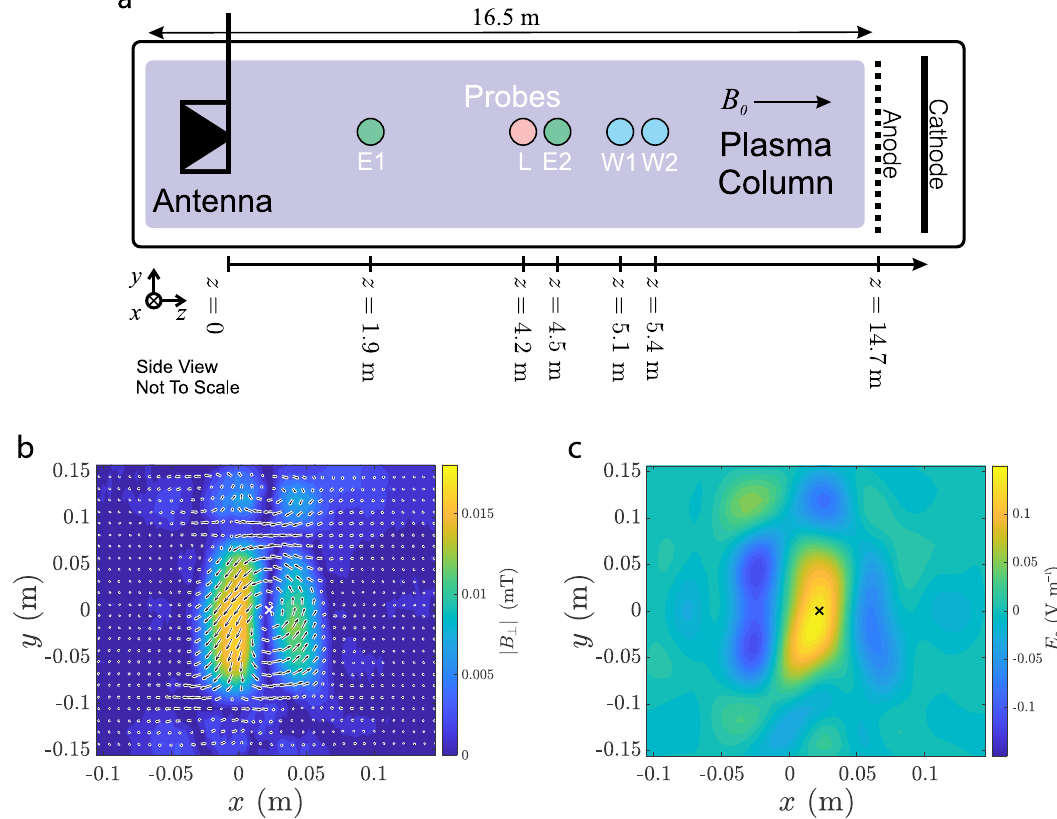
Fig. 1 LAPD setup and snapshots of the Alfvén wave. a Experimental setup showing the Sigma antenna, Elsässer probes (E1, E2), Langmuir probe (L), and WWAD probes (W1, W2). b Contour plot of B ⊥ ( x , y ) of the inertial Alfvén wave in the plane perpendicular to B 0 measured at E2. Arrows indicate the magnitude and direction of B ⊥ ( x , y ). c The calculated E z ( x , y ) midway between the WWAD probes W1 and W2. The x indicates the ( x , y ) location of the WWAD measurements of g e ( v z